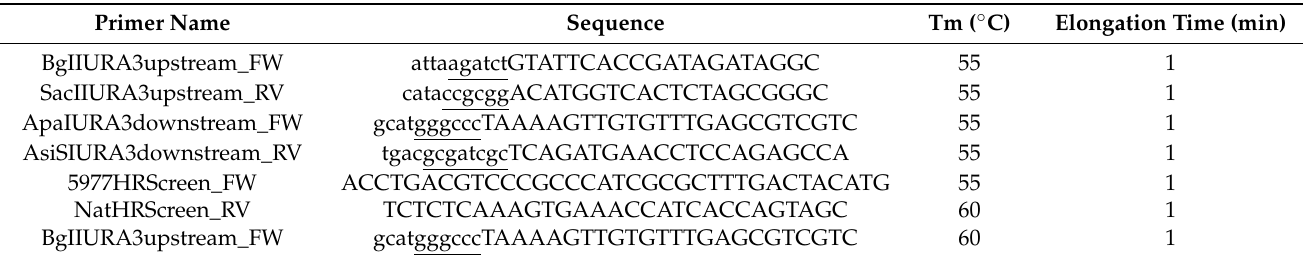
Table 2. Primers used. Capital letters anneal to the targeted DNA whereas lowercase letters are additions to the primer. Underlined letters form a recognition site for a restriction